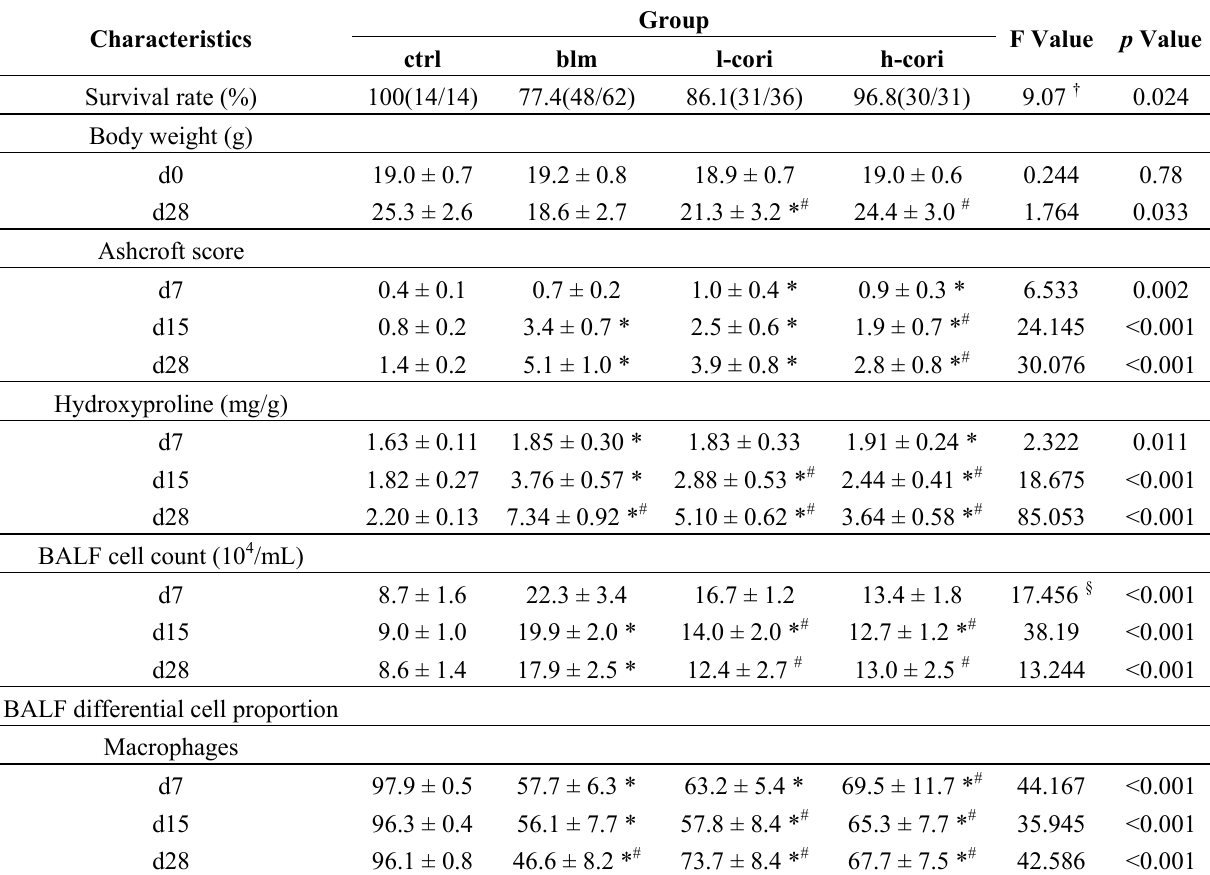
Table 1. The hydroxyproline content, fibrosis score and BALF cell count in four groups (mean ± SD, n = 5 or 7 for each